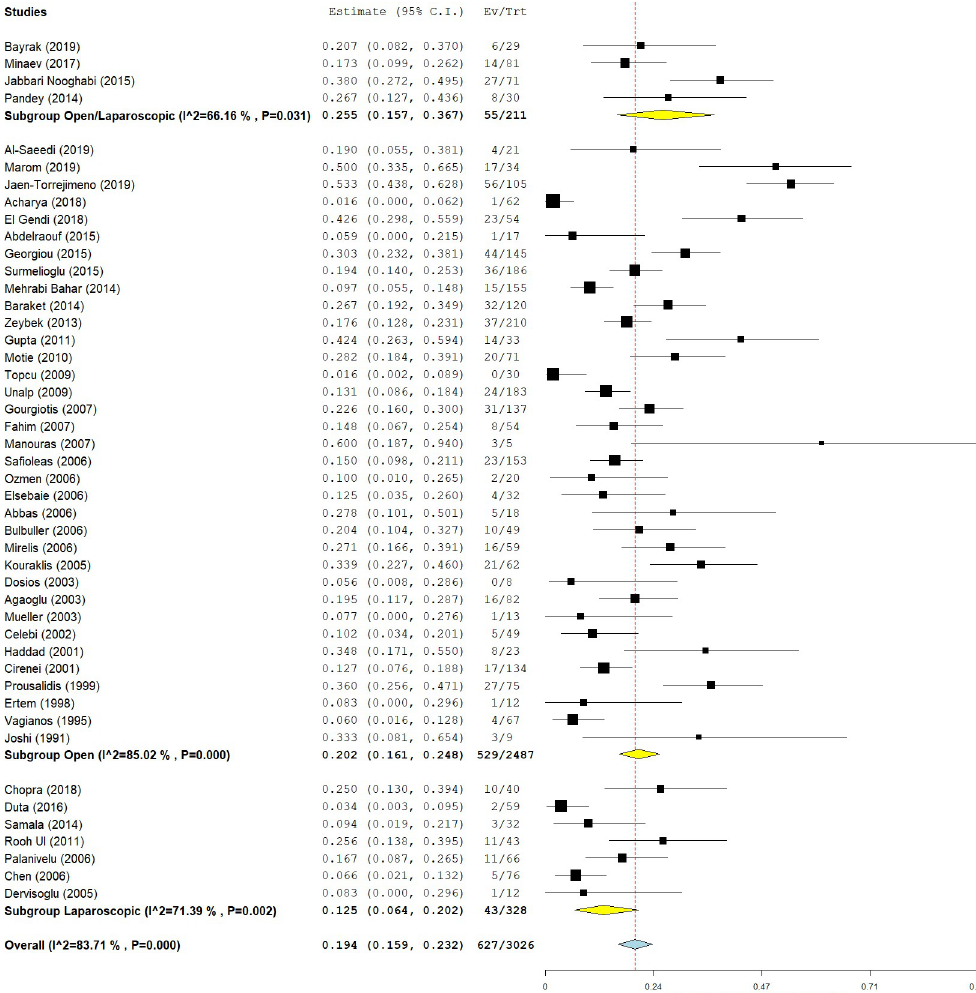
Fig 3. Forest plot of the postoperative complication rate after endocystectomy for cystic echinococcosis, with subgroup analysis of laparoscopic and open surgeries. Complications were classified according to residual cavity management in 18 studies (33.3%). Complication rates were higher in the marsupialization group (10/23 patients; 43.5%), followed by the capittonage group (18/71 patients; 25.3%), the drainage group (70/317 patients; 22.1%), and the omentoplasty group (69/366; 18.8%). The complication rate was 17.5% in the group with no cystic residual cavity management (41/234 patients). Chi-square analysis revealed a statistically significant difference between different techniques of residual cavity management (p-value = 0.02). Further post-hoc analysis showed no significant correla- tion between postoperative complications and residual cavity management techniques. Marsu- pialization showed a non-significant trend for a higher complication rate compared with other techniques (post-hoc p-value = 0.006; significance level after Bonferroni correction < 0.005). The post-endocystectomy mortality rate was reported in 40 studies (74%) including 2706 patients. The all-cause mortality was 1.2% (95% CI: 0.8–1.8 I 2 = 21%; p-value = 0.15) (Fig 4). Of these, the cause of death was not described in ten patients (35.7%), eight patients died of septic shock (28.5%), three patients died of hemorrhage (10.7%), two patients died of